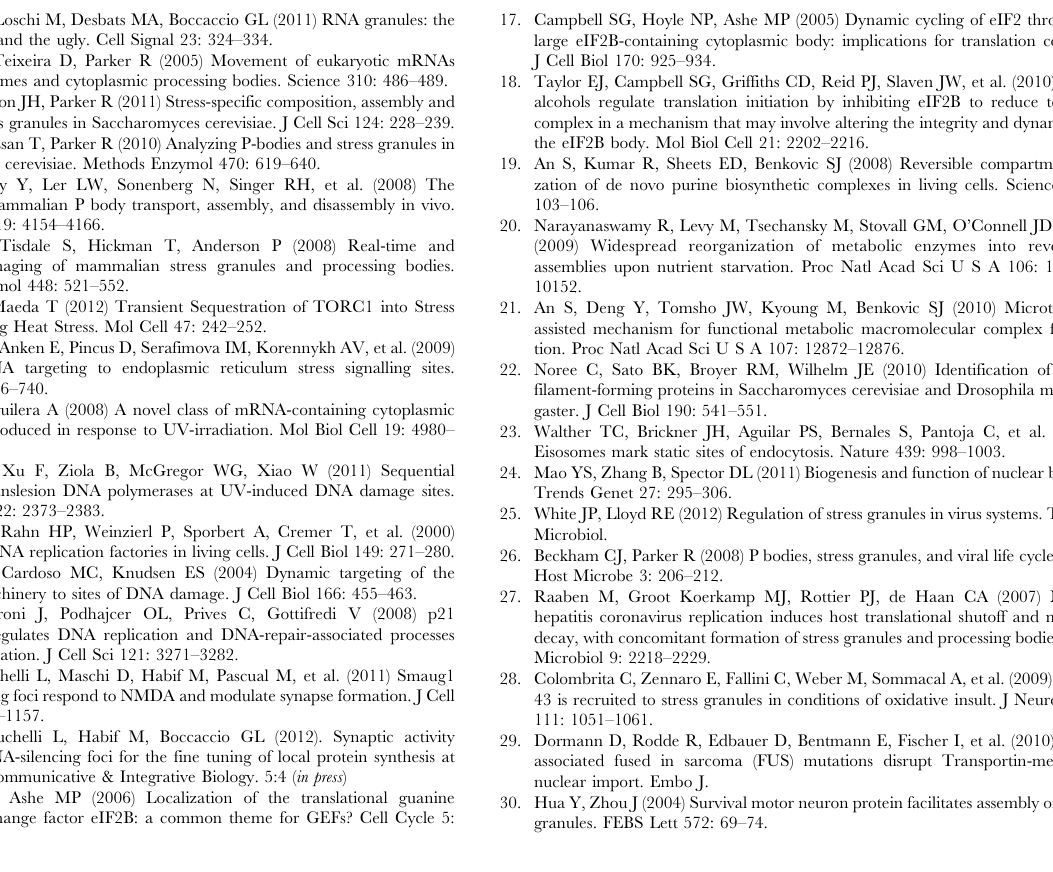
Figure S2 Redundant identification by rotated